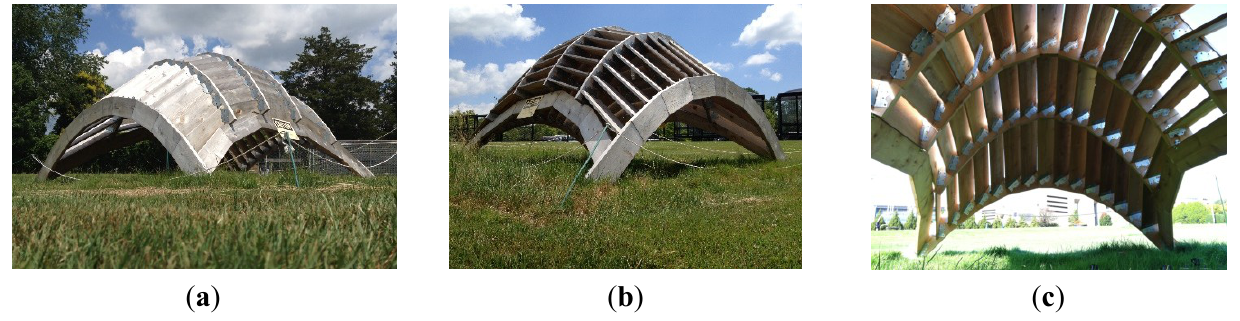
Figure 5. ( a ) South-West; ( b ) North-West elevation; ( c ) inside view of the louvered grid shell prototype built.